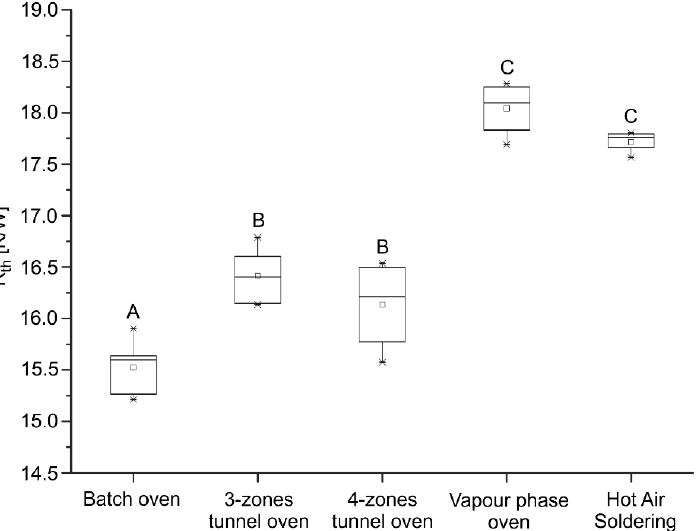
Figure 5. Thermal resistance ( R th ) of NGB8207BN transistors soldered onto FR4 substrate in different soldering ovens.